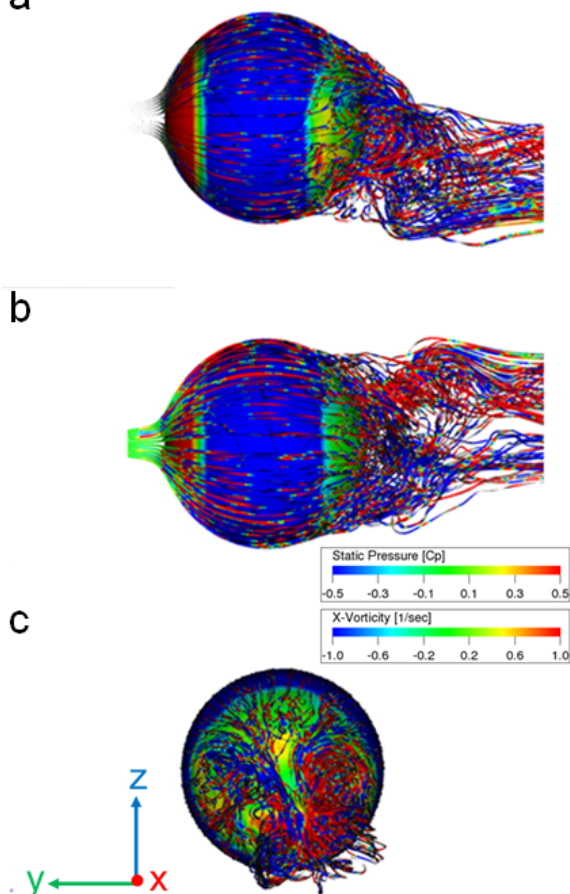
Figure 5. Example of static pressure and x-vorticity seen on streamlines around a nonspinning soccer ball obtained using CFD from ( a ) side view, ( b ) top view, and ( c ) back view. On the other hand, the boundary layer separation points and pressure distribution in the case of Spin B of a spinning ball ( ω = 50.2 rad/s, Re = 4.25 × 10 5 ) deflected under the influence of rotation, and